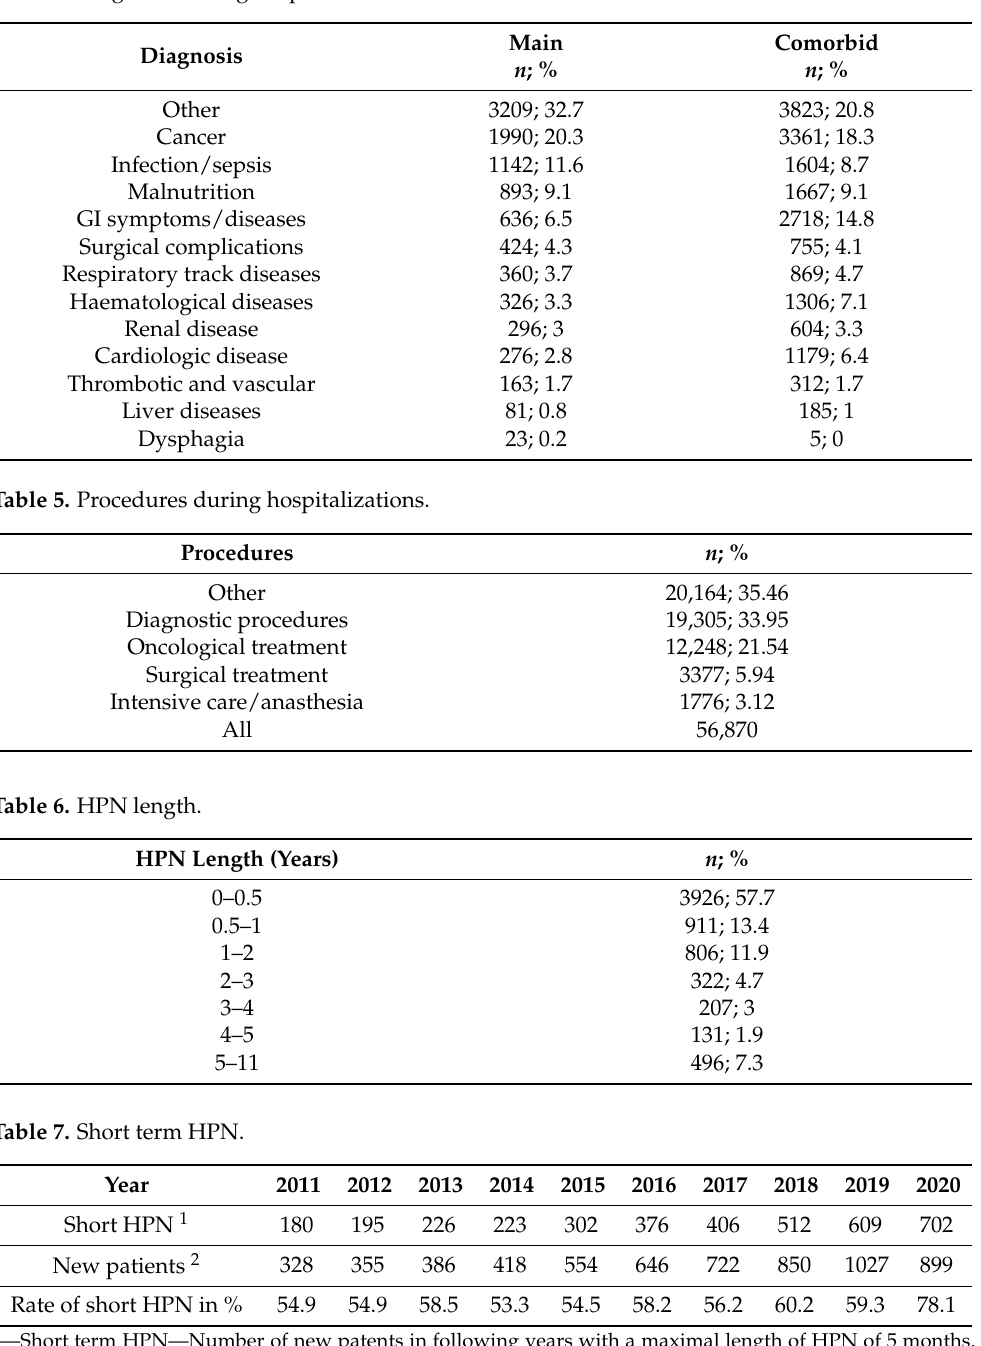
Table 4. Diagnosis during hospitalizations.